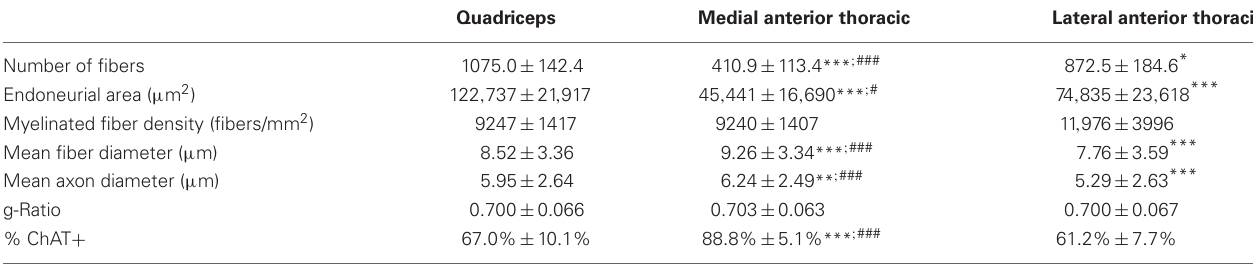
Table 1 | Morphometric parameters of myelinated fibers of the lateral and medial anterior thoracic and quadriceps nerves. Quadriceps Medial anterior thoracic